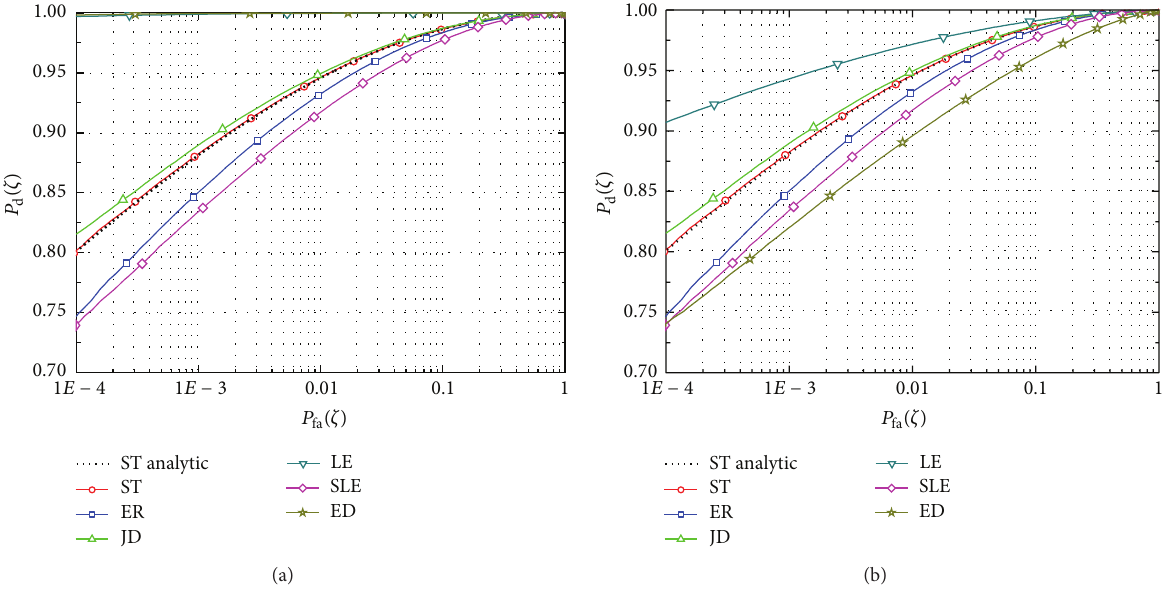
Figure 14: ROCs over a Rayleigh fading channel, for 𝐾 = 4, 𝑁 = 100, 𝑃 = 6, SNR 1 = 0 dB, SNR 2 = − 1dB, SNR 3 = − 3dB, SNR 4 = − 8dB, SNR 5 = − 10 dB, and SNR 6 = − 22 dB, with 𝜇 = 0dB (a) and 𝜇 = 0 . 5 dB (b) for the LE and the